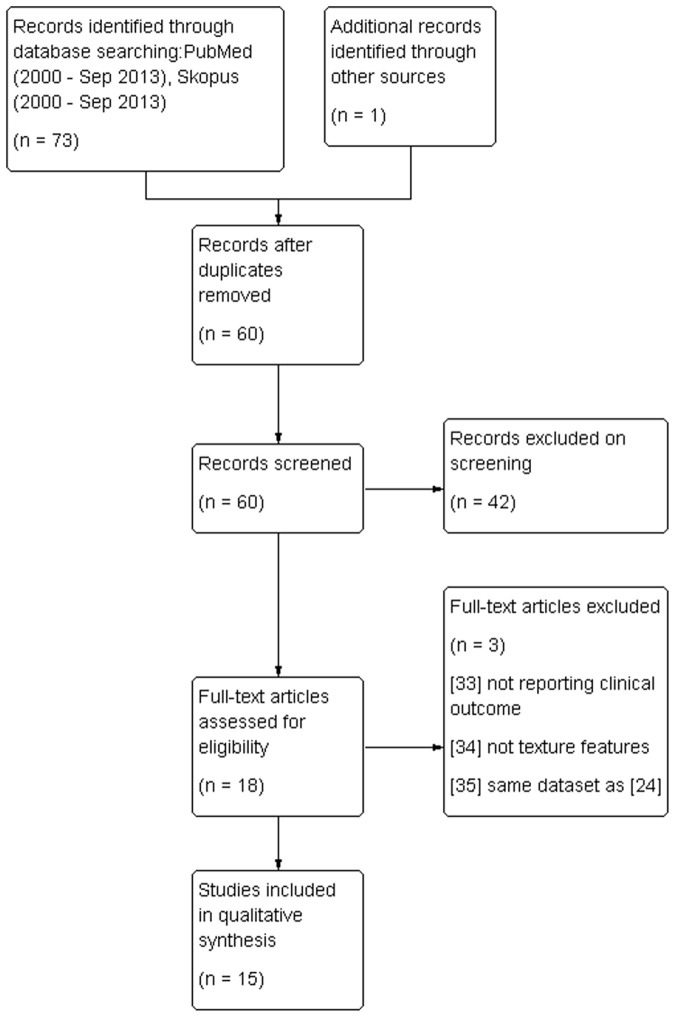
Study flow diagram according to PRISMA guidelines.